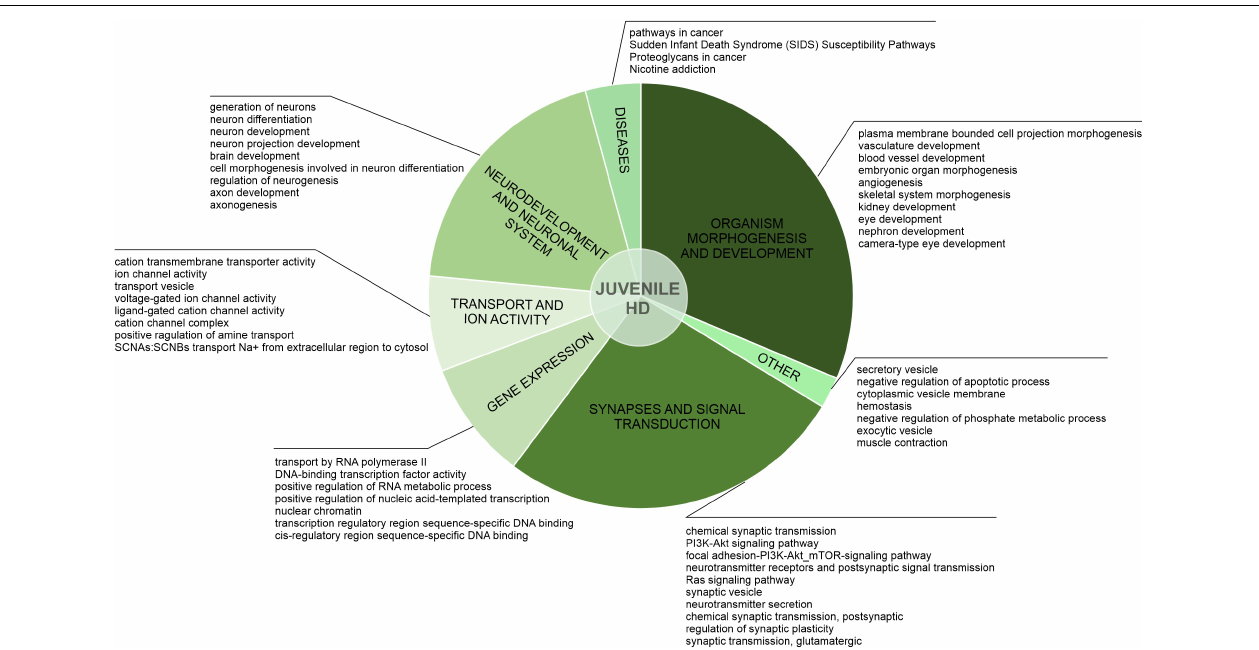
FIGURE 3 | Uniquely downregulated DEGs in JOHD are involved in developmental processes, organism morphogenesis, and signal transduction. A pie-chart with a ClueGO analysis of genes downregulated only in neurons from juvenile-onset HD patients was used to visualize the biological processes they are involved in. Top dysregulated processes for each bigger cluster were